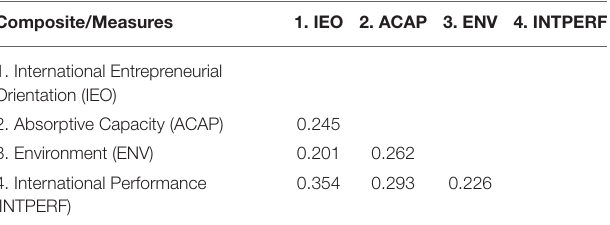
TABLE 7 | Heterotrait-Monotrait (HTMT)